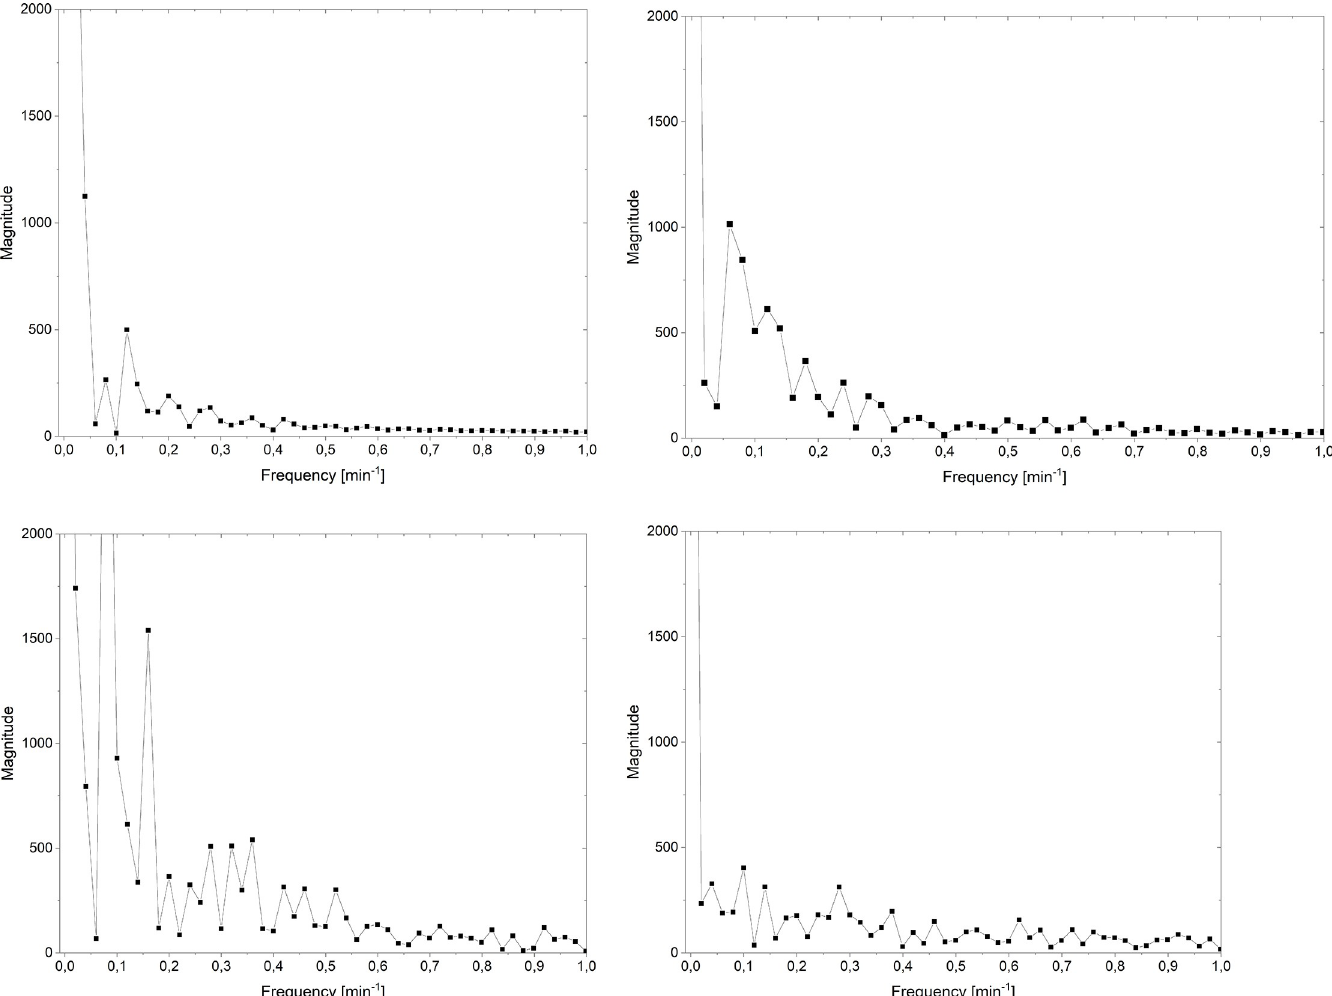
Fig 8. Magnitude of Fourier analysis of voltage in the membrane system in a selected range of time as a function of frequency for initial conditions: C h / C l = 100 (a), C h / C l = 500 (b), C h / C l = 1000 (c), C h / C l = 5000 (d).